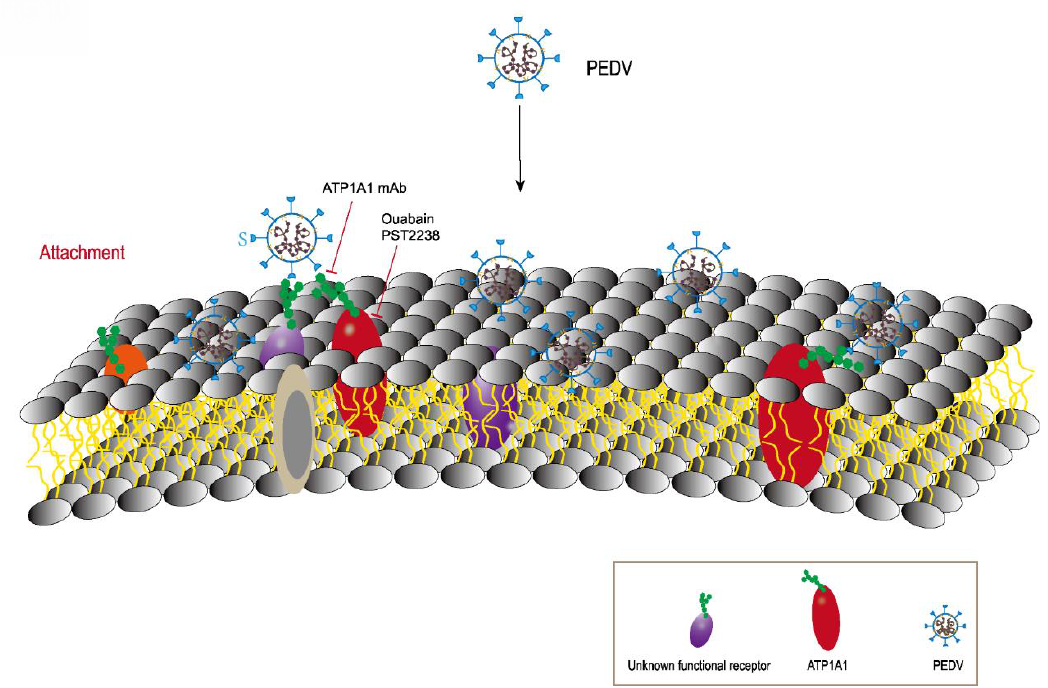
Figure 10. A model describing the involvement of ATP1A1 in PEDV attachment. ATP1A1 plays an important role as a host factor that facilitates PEDV attachment. Overall, ATP1A1 is involved in recognition of hosts together with unknown functional receptors. ATP1A1 mAb interferes with the recognition of ATP1A1 and PEDV on the cell surface and inhibits viral infection. ATP1A1-specific inhibitors treatment leads to partial internalization and degradation of ATP1A1, reducing viral recognition.